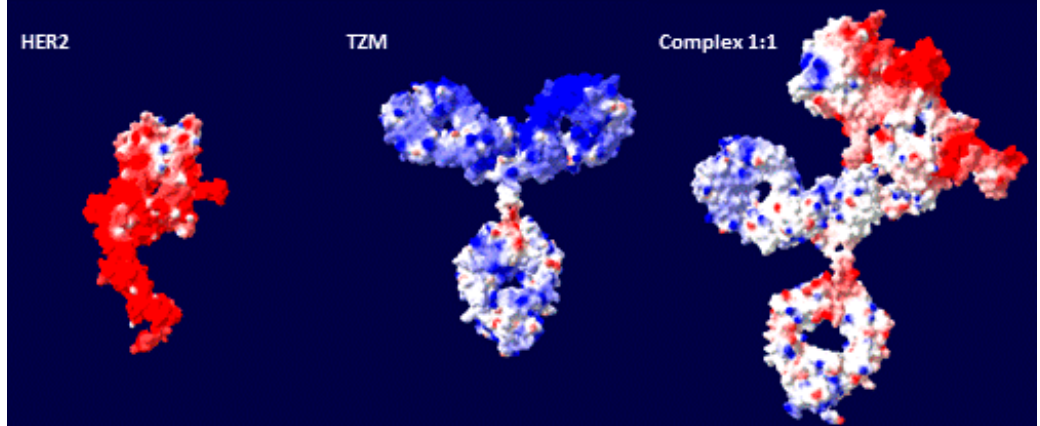
Figure 8. Distribution of the electric charge at the molecular surface of the systems under study. The molecular surface is colored as follows: red (negative cutoff − 2.0 k B T/e), white (neutral points), blue (positive cutoff +2.0 k B T/e) color gradient. The simplest calculation for the electrostatic potential (Coulomb) has been selected as a first approach, using the Deep View (Swiss-PdbViewer) package [64].